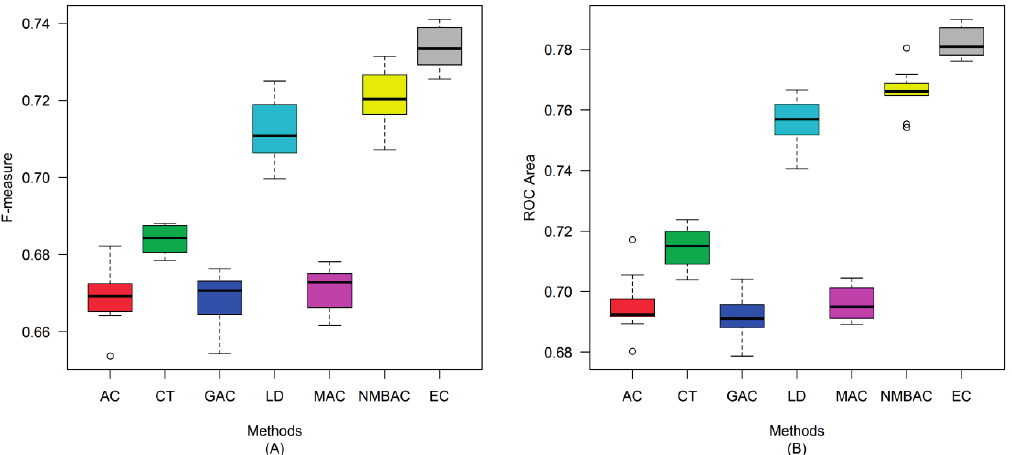
Figure 9. Average F-measure and Receiver Operating Characteristic (ROC) area of different methods on the Gold Yeast dataset with five-fold cross-validation. ( A ) F-measure; ( B ) ROC